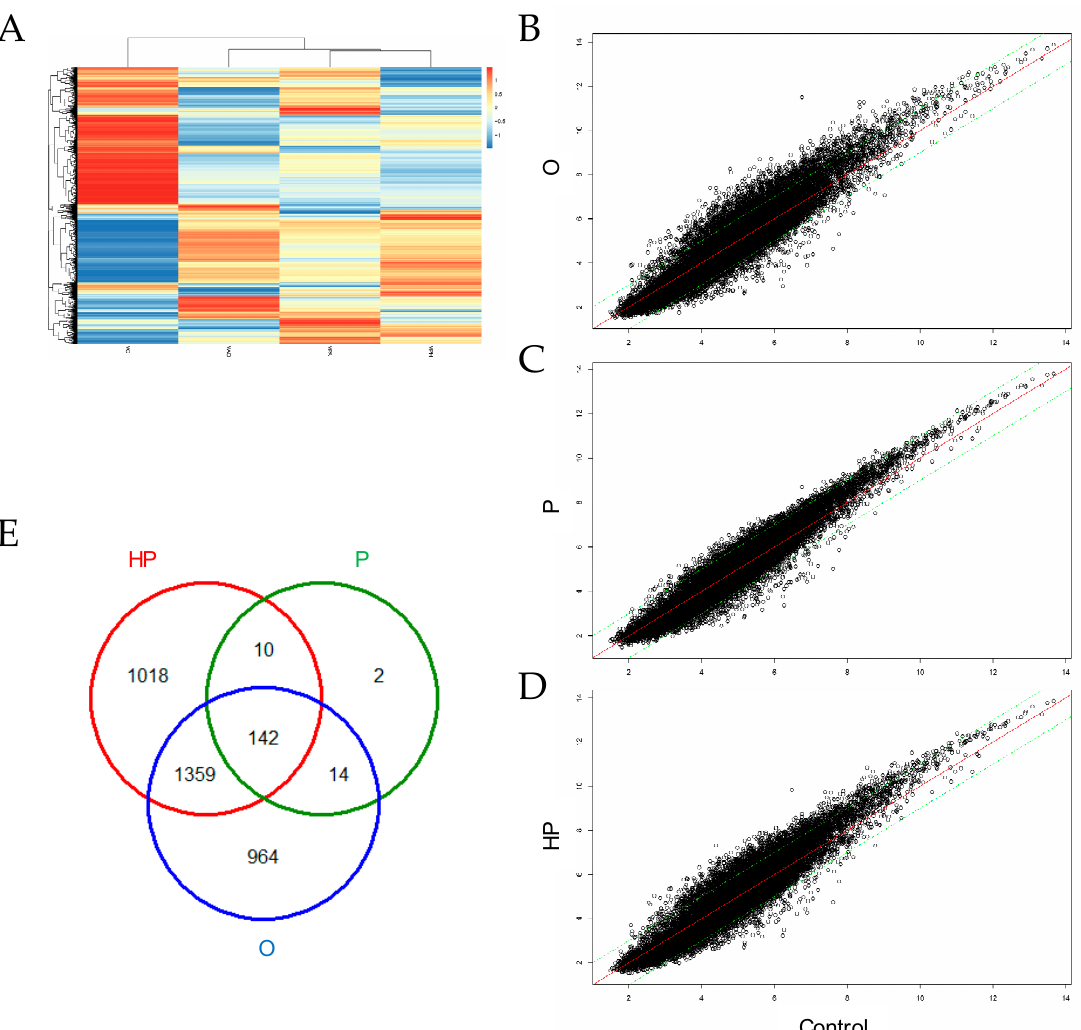
Figure 6. Liver gene expression analysis. ( A ) Heatmap of microarrays data of different dietary groups. Scatter plots in mice liver receiving either olive oil ( B ), palm oil ( C ), or hybrid palm oil ( D ). ( E ) Venn diagram showing the intersections of differentially expressed genes. O, olive oil group; P, palm oil group; HP, hybrid palm oil group.